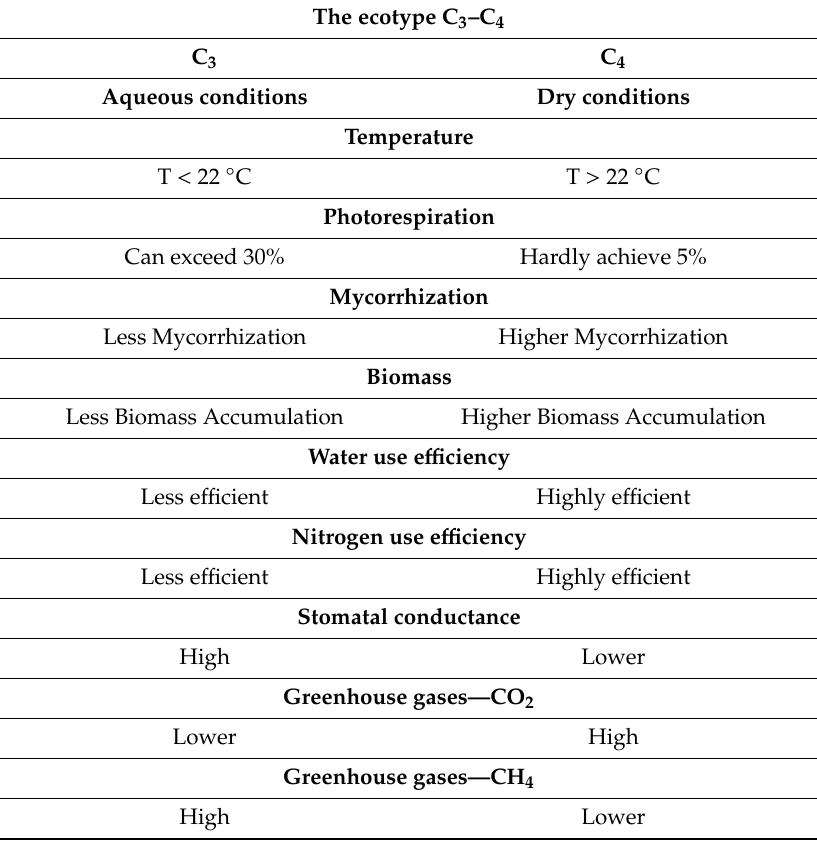
Table 1. The C 3 –C 4 ecotype of Phragmites australis . Modified from References